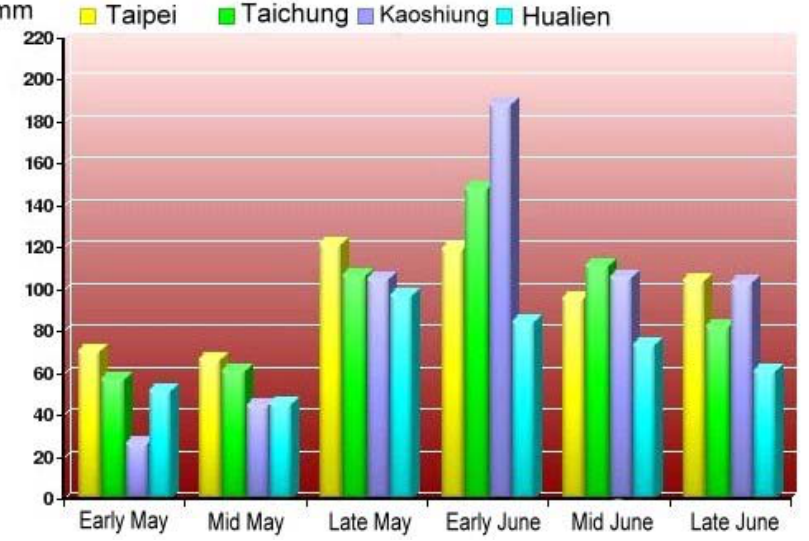
Figure 6. Geographical distributions of the average accumulated rainfalls (Courtesy of CWB, Taiwan).